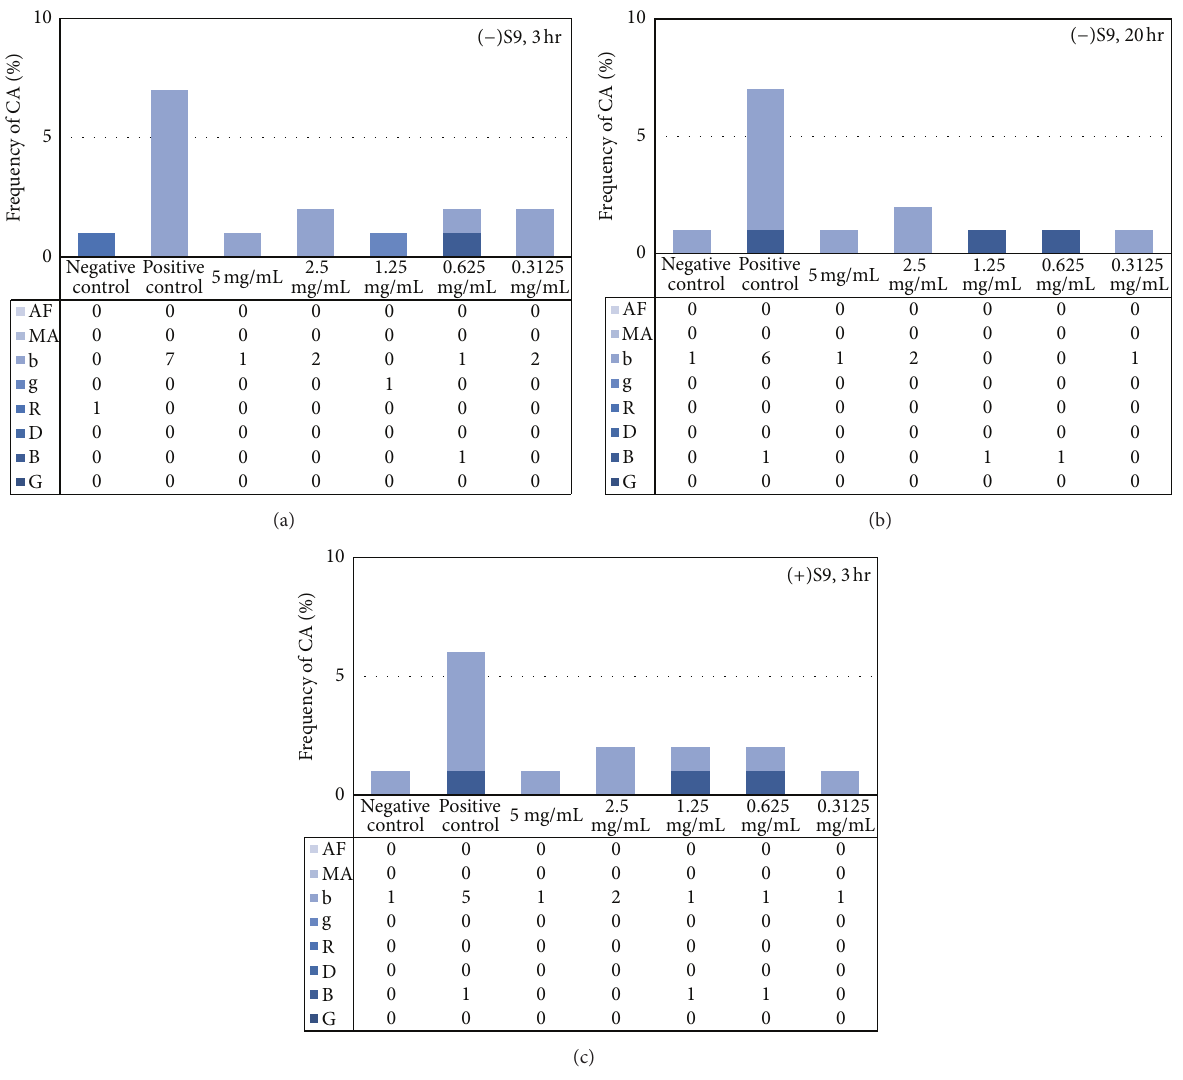
Figure 2: The multispecies probiotic mixture does not provoke the frequency of chromosomal aberration (CA) in mammalian cell culture. (a) Three hour exposure to test substances followed by 17-hour recovery period. (b) Continuous 20-hour exposure to test substance. (c) Metabolic activation of test substance by cotreatment with S9 mix for 3-hours followed by 17-hour recovery period. AF: acentric fragment; MA: multiple aberrations; b: chromatid break; g: chromatid gap; R: ring; D: dicentric; B: chromosome break; G: chromosome